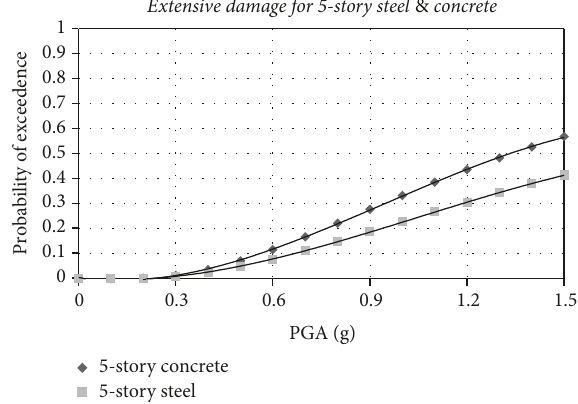
Figure 10: Comparison of the fragility of the 8-story steel and RC frame buildings for the complete damage state.